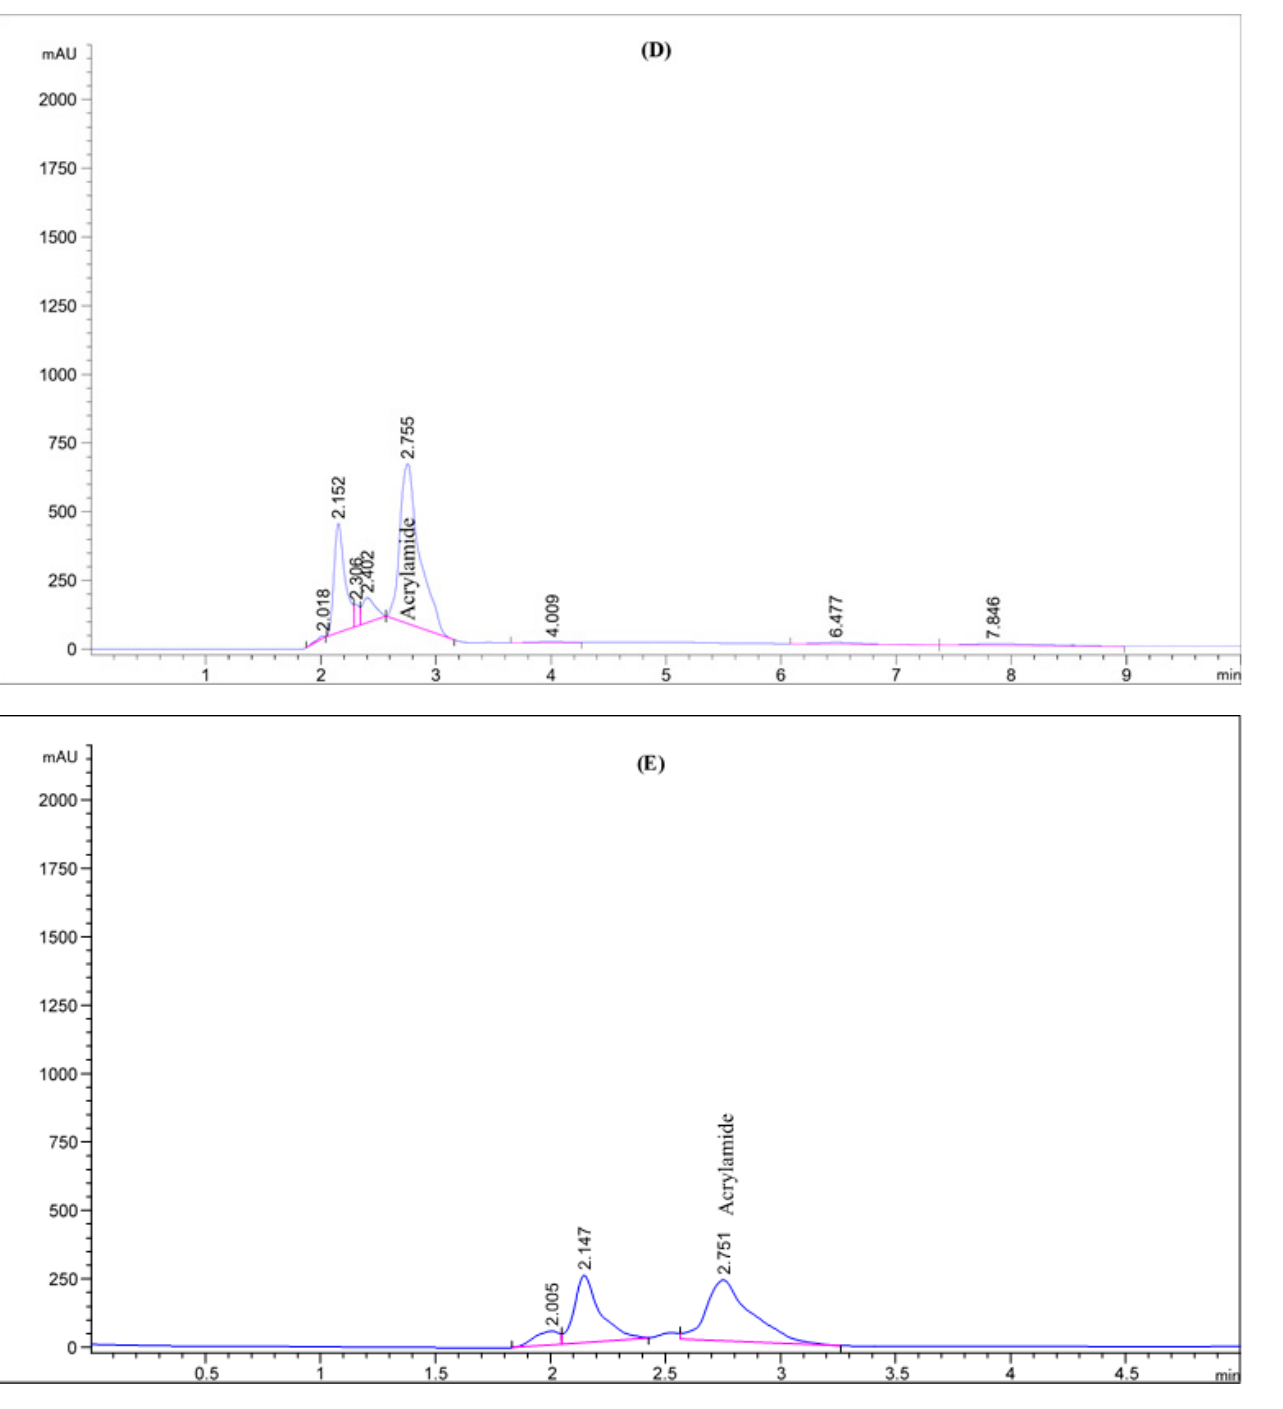
Figure 2. HPLC chromatogram of acrylamide in various fried potato chips ( A ) control; ( B ) soaked in pomegranate peels extract; ( C ) soaked in olive leaves extract; ( D ) soaked in potato peels extract; ( E ) soaked in lemon peels extract.